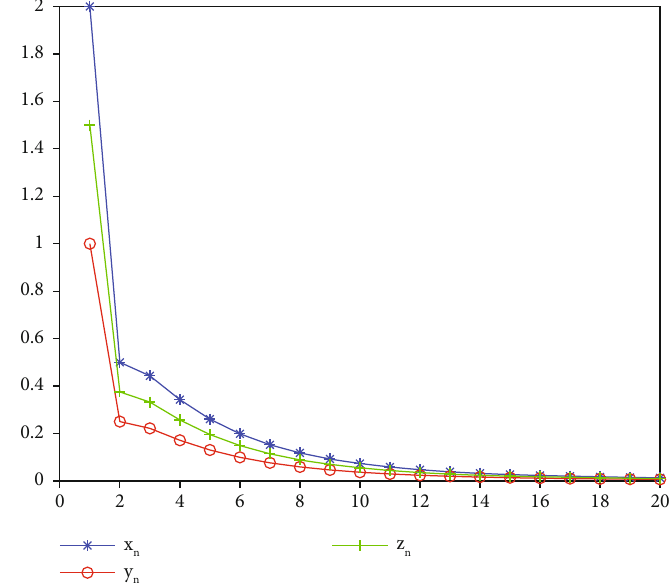
Figure 3: Convergence behavior f x